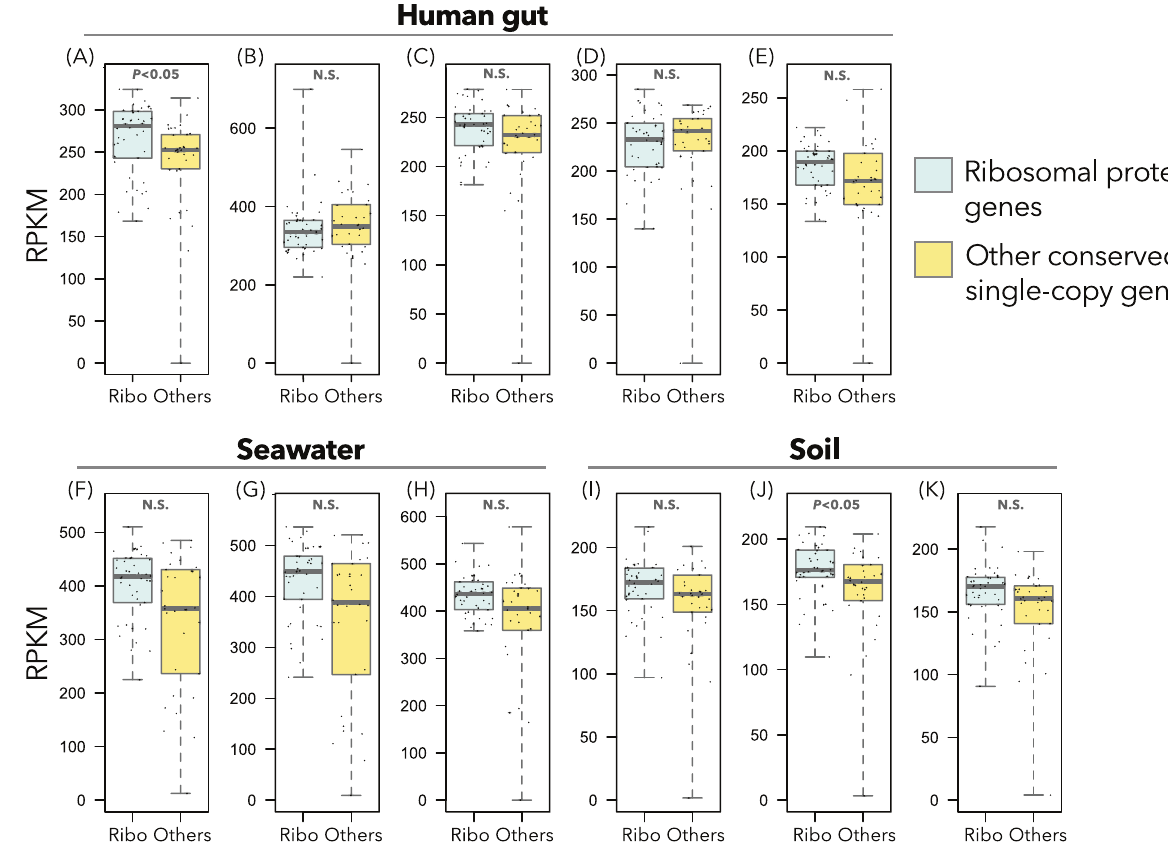
Fig. 2 Frequencies of reads coding ribosomal protein genes and other widely conserved single-copy genes in unassembled short-read shotgun metagenomes. Each panel indicates one metagenomic sample, and each dot in a panel represents the RPKM of one ortholog (i.e., the number of reads normalized by the length of that ortholog and sequencing depth). Statistical signi fi cance (Brunner – Munzel test with Bonferroni ’ s correction) is shown at the top of each panel. Panels A – E , F – H , and I – K are the results from human gut metagenomes, seawater metagenomes, and soil metagenomes, respectively. N.S. not signi fi cant, Ribo ribosomal protein ribosomal protein gene, an average operon length on the fi ve genomes was calculated. Those lengths were compared with proportions of MAGs harboring those genes for each of the fi ve MAG datasets (short-read MAGs only). Analysis of CRISPR and transposase genes We then compared the frequencies of the losses of ribosomal protein genes and the amount of other known hotspots of binning errors (i.e., CRISPR and transposase genes) in MAGs. Each MAG with >90% completeness from seawater, the human gut, and the GEM was coupled with a phylogenetically close genome from RefSeq to compare MAGs and genomes from pure isolates. Seawater and human gut MAGs were coupled with GTDB genomes closesttoMAGs asdetermined byGTDB-Tk. The MAG was excludedfromthis analysis if the coupled GTDB genome was unavailable in RefSeq (note that GTDB contains GenBank genomes that were ruled out from RefSeq). Regarding MAGs in GEM, counterpart genomes were determined based on the genomic operational taxonomic units de fi ned in the GEM. The operational taxonomic units in the GEM consisted of one or more genomes from MAGs and RefSeq. For each MAG, one RefSeq genome, if any, was randomlyselected from the same operational taxonomicunit.Otherwise, the MAG was not used in the analysis. We predicted CRISPRs in each pair of MAG and its counterpart RefSeq genome using CRISPRCasFinder version 4.2.20 [47] with default parameter settings. We counted the number of CRISPR sequences with evidence levels of three or higher. We also predicted genes encoding transposases using Prodigal and KofamScan in these genome pairs. We did not compare ribosomal protein genes between the MAGs and RefSeq genomes because RefSeq excludes genomes lacking ribosomal protein genes (https:// www.ncbi.nlm.nih.gov/assembly/help/anomnotrefseq/; accessed August